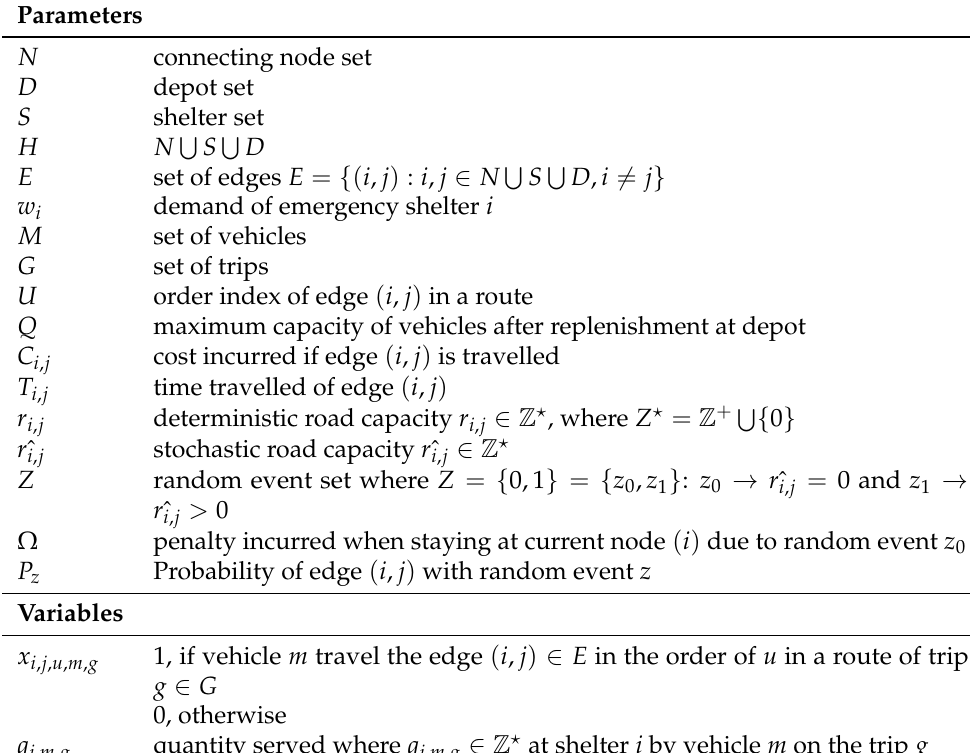
Table 1. Parameters and Variables for D-MDVRPRC and